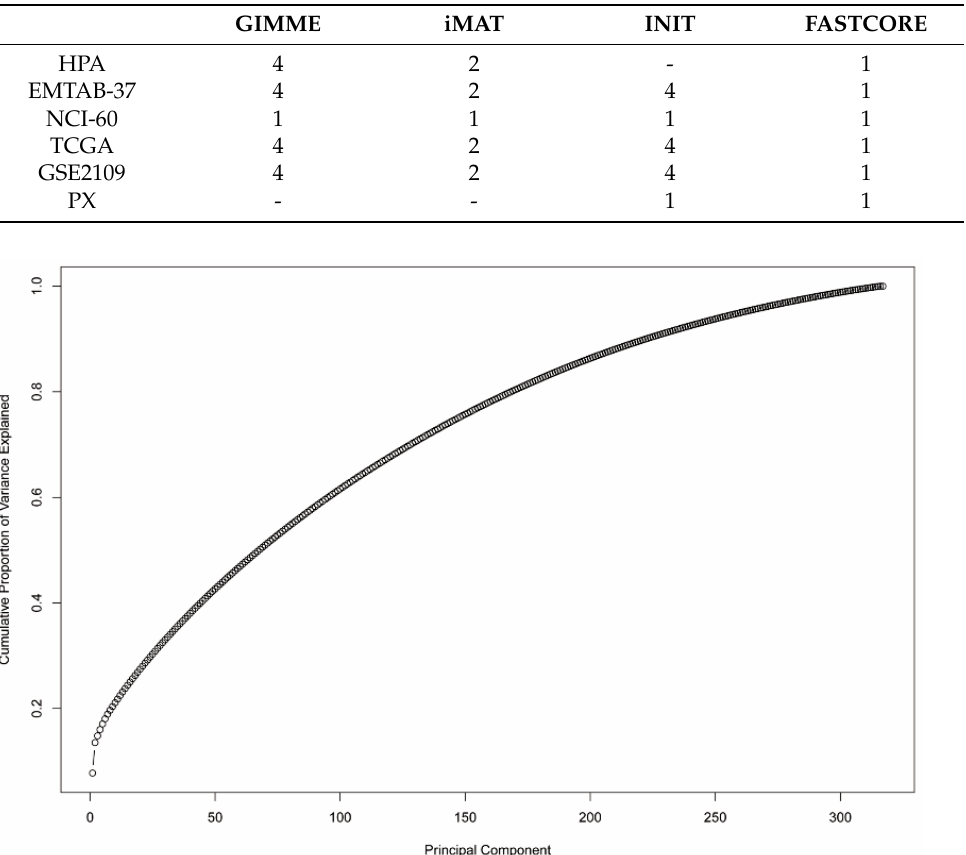
Figure 5. The Bland–Altman plot for flux states of skin melanoma GEM and pancreas carcinoma GEM in EMTAB-37–GIMME method (hypothesis mean = 0 rejected by p -value < 0.0001). Table 7. The number of clusters, which were determined by the first two principal components.